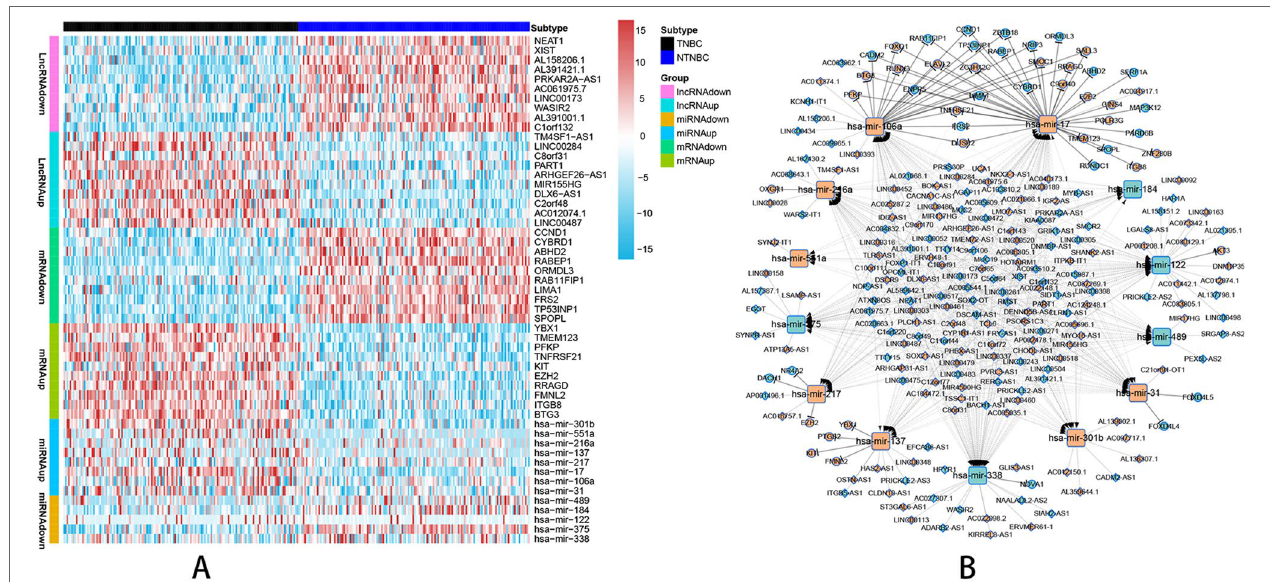
FIGURE 1 | Visualization of the ceRNA network analyzed by differential screening and database comparison. (A) Heat map showing differences in gene expression between 150 TNBC samples and 150 nTNBC samples picked up randomly in 823 nTNBC samples by randomly selecting 10 RNAs from each RNA type except miRNAs. (B) CeRNA network containing 251 nodes and 598 edges in breast cancer demonstrated pair bonds among lncRNA–miRNA–mRNA. Diamonds, squares, and circles represent lncRNAs, miRNAs, and mRNAs, respectively. Light blue indicates upregulated genes in nTNBC subtype, and red–orange indicates upregulated genes in TNBC